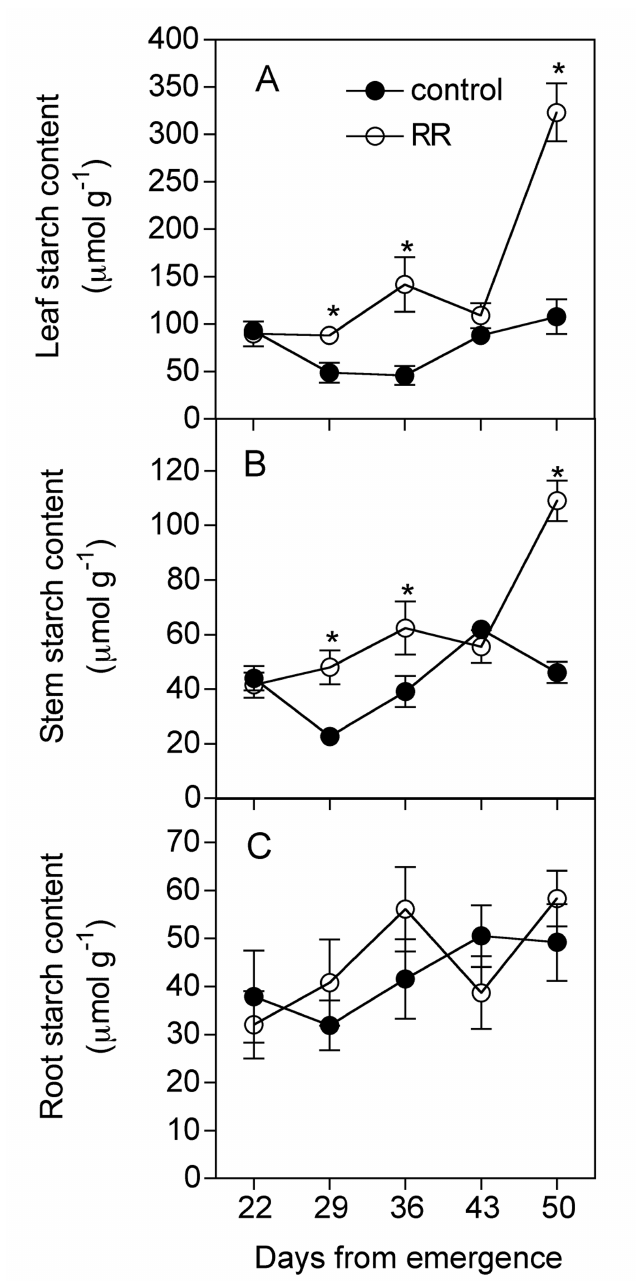
Fig. 4 - Sugar content measured at weekly intervals from day 22 to the end of the experiment in both control and root-restricted (RR) plants: total sucrose (A), total glucose (B), total fructose (C) and total starch (D). * indicates significantly different values for P≤0.05 (n=5), when means were separated by Duncan’s test.